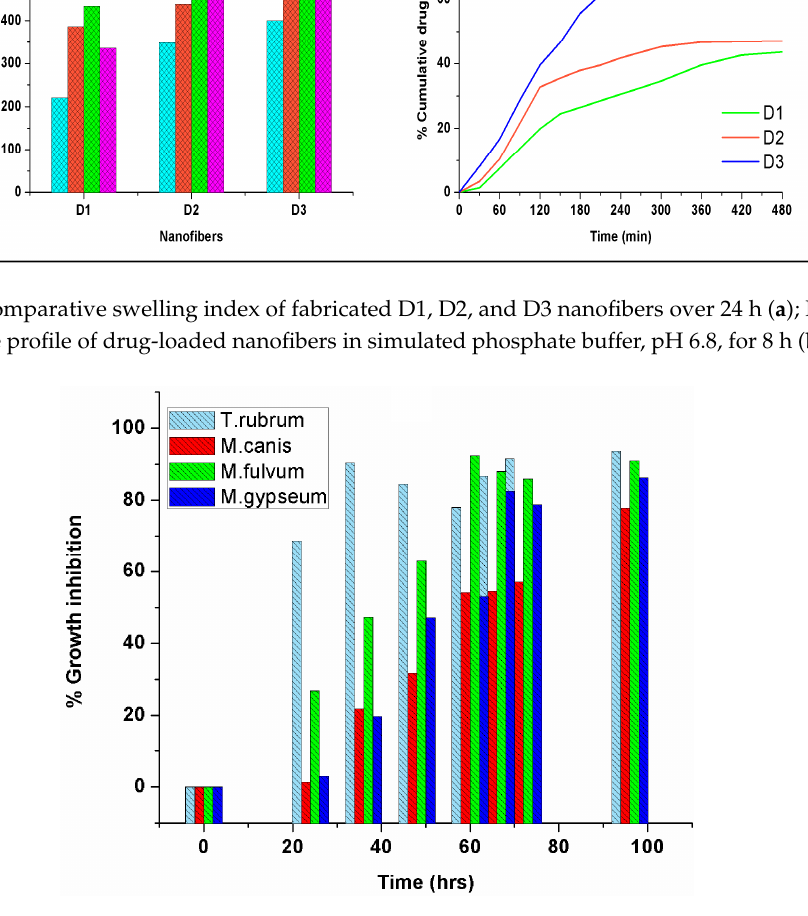
Figure 6. In vitro antifungal study of D3 nanofibers against T. rubrum , M. canis , M. fulvum , and M. gypseum for 96 h.